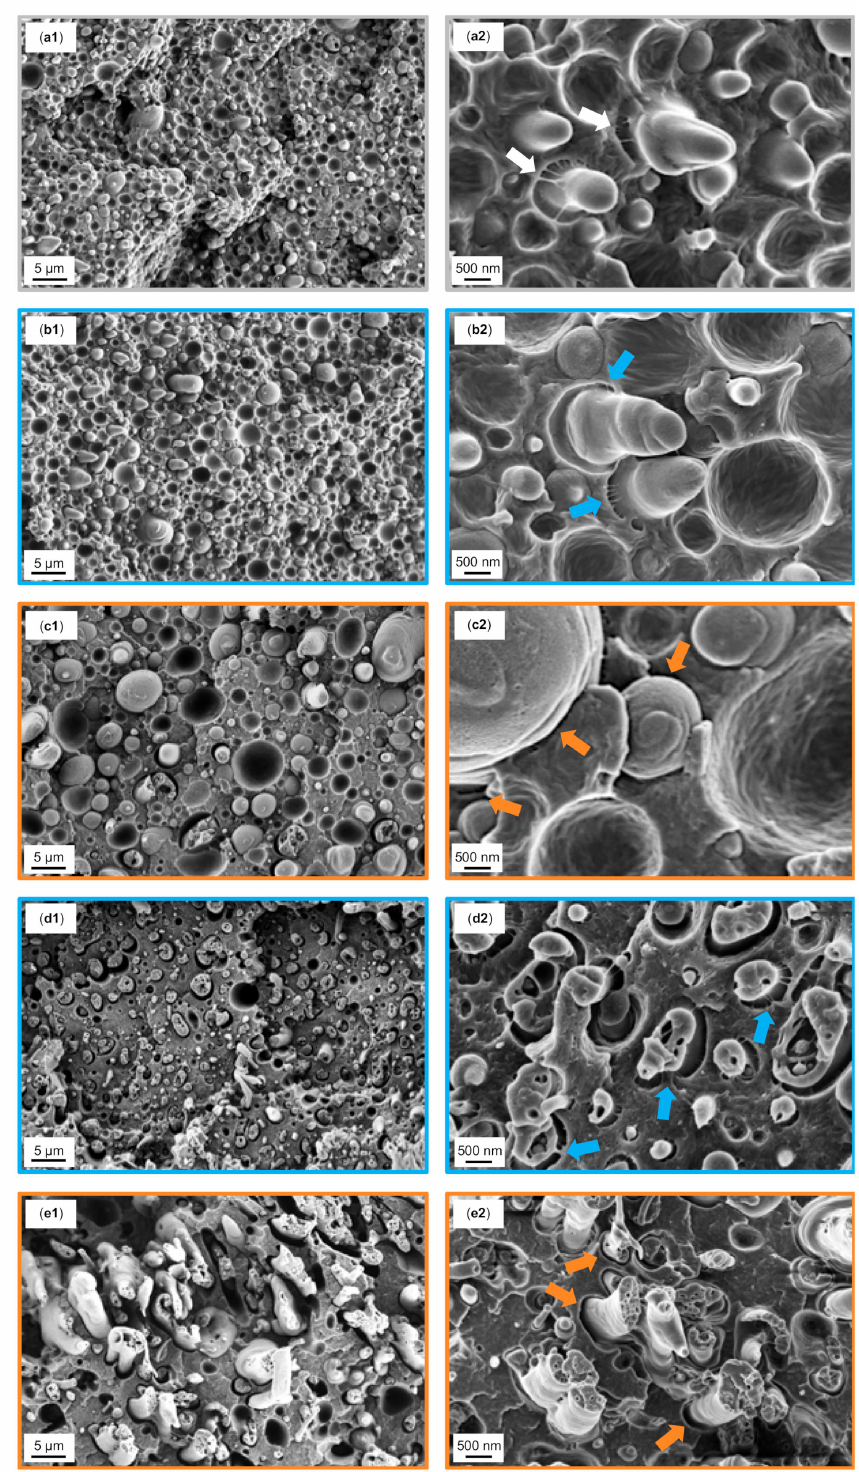
Figure 8. SEM fractographs after tensile tests of the reference binary blend ( a 1), 1.25 wt% SMA low ( b 1) and 1.25 wt% SMA high ( c 1), 10 wt% SMA low ( d 1), 10 wt% SMA high ( e 1), and their corresponding graphs at higher magnifications on the right column ( a 2, b 2, c 2, d 2 and e 2). The white arrows in Figure ( a 2) indicate strong matrix fibrillations, while the blue arrows in Figure ( b 2 and d 2) indicate intermediate fibrillation, and the orange arrows in Figure ( c 2, e 2) indicate weak